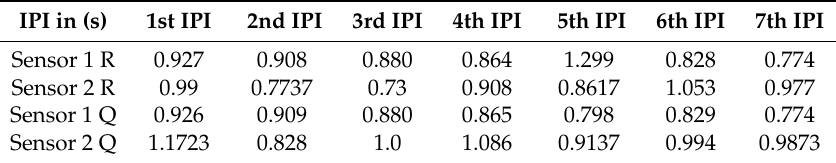
Table 2. Results for two sensors of the Simulink